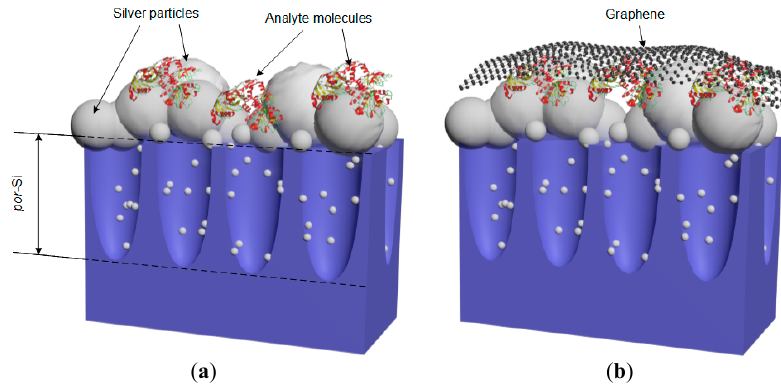
Figure 3. Schematic views of the SERS-active substrates: ( a ) The silvered por -Si with adsorbed analyte molecules; ( b ) the silvered por -Si with adsorbed analyte molecules coated with graphene.